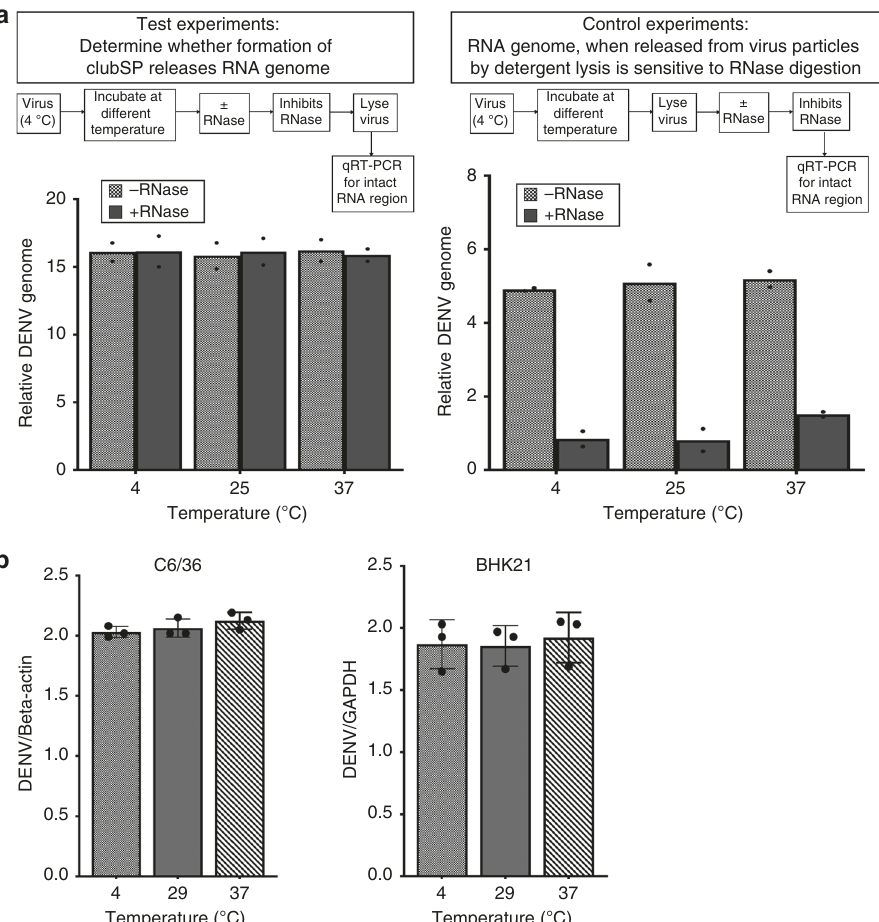
Fig. 2 DENV3-CH53489 clubSPs contain RNA and remain infectious. a The viral DENV3-CH53489 RNA genome is not extruded out of the particle after temperature-induced structural change at 25 and 37 °C. (Left panel) Viruses at 4 °C were transferred to different temperatures and incubated for 30 min. RNase is then added to digest away any RNA genome that was extruded outside the virus. RNase activity is inhibited and then the virus was lysed. Detection of a 260-nucleotide stretch of RNA genome using a primer set in qRT-PCR indicates intact viral genome. In all temperatures, the amount of genome with and without addition of RNase appeared the same, suggesting that viral RNA remains within the particle after temperature treatment and were thus protected from RNase treatment. The y -axis is expressed as difference in Cq values from virus-free reference. (Right panel) Control experiments to show when virus is lysed fi rst before exposure to RNase, the RNases can successfully break down viral RNA genome. Results showed that when RNA genomes (due to lysis) are exposed, RNases digestion occurs and there are much lower amounts of intact RNA genome detected by qRT-PCR than when no RNase is added. b Attachment assay showing 29 and 37 °C pretreated viruses containing clubSPs have the same binding capacity to both C6/36 and BHK21 cells as the 4 °C sample. Data are presented as mean and error bars represent SD calculated from three individual experiments; each experiment was done in duplicate. The y -axis shows the relative DENV3-CH53489 RNA against housekeeping genes: beta-actin and GAPDH for C6/36 and BHK21 cells, respectively. Source data are provided in the source data fi